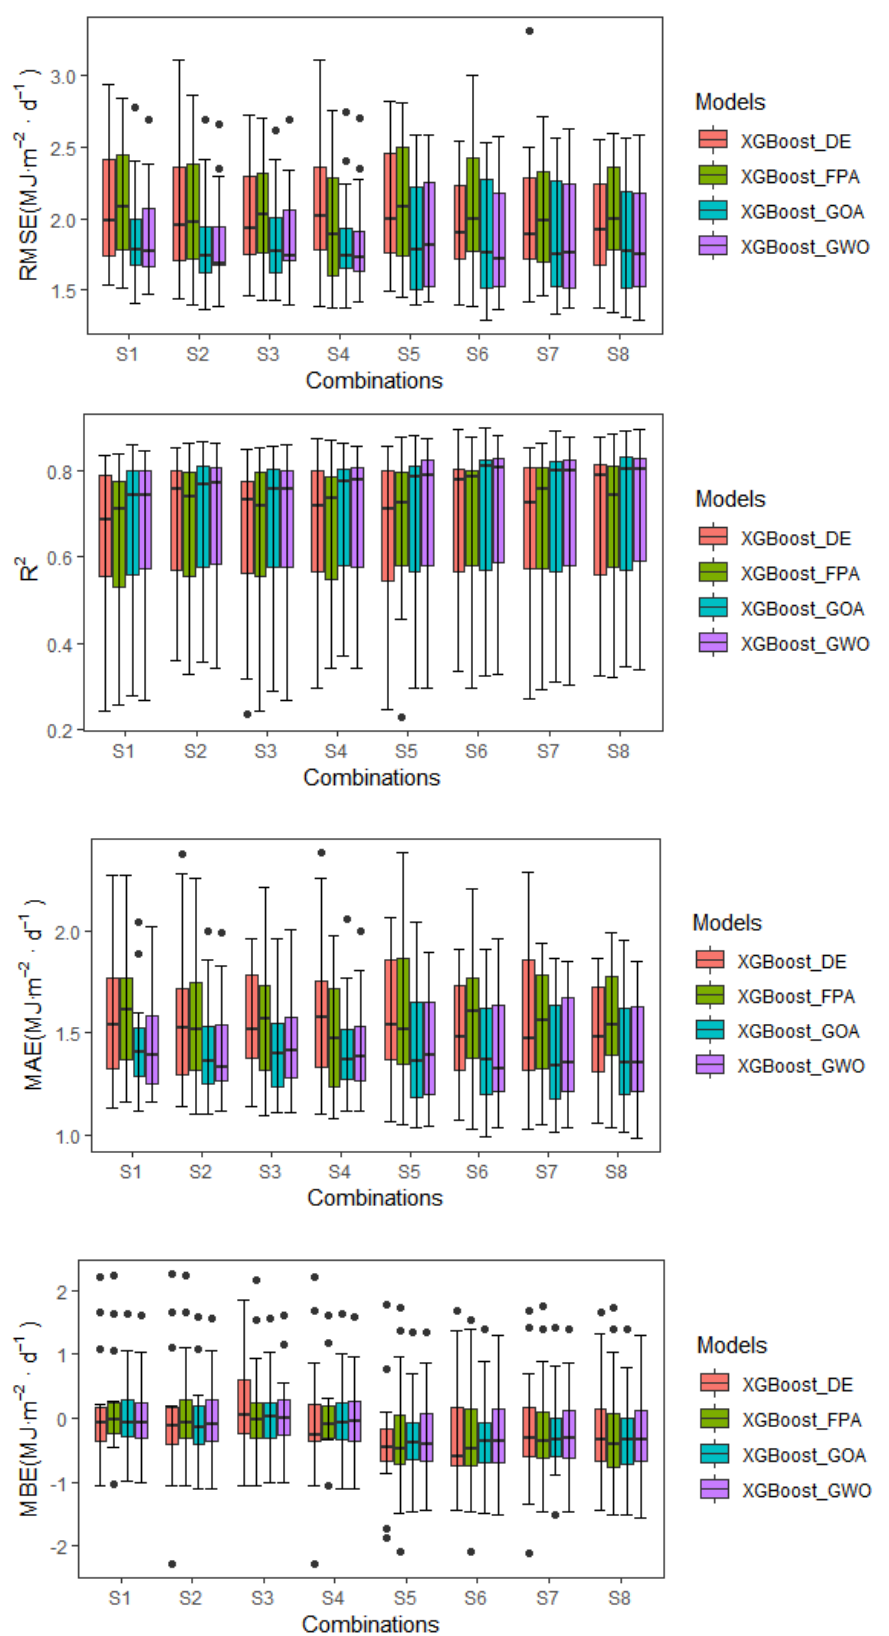
Figure 2. Sca tt er plots of R d predicted by the coupling models based on Himawari-7 data in Bei- jing.